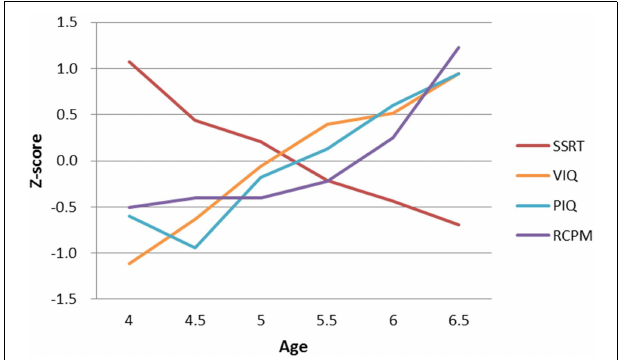
FIGURE 2 | Developmental trajectories of SSRT and different types of IQ. Both SSRT and VIQ showed a steady progression of development between the ages of 4 and 6.5 years, but PIQ and RCPM began to develop much later, at around ages 5–6. (SSRT, stop-signal reaction time; VIQ, Verbal IQ score; PIQ, Performance IQ score; RCPM, Raven’s Colored Progressive Matrices).